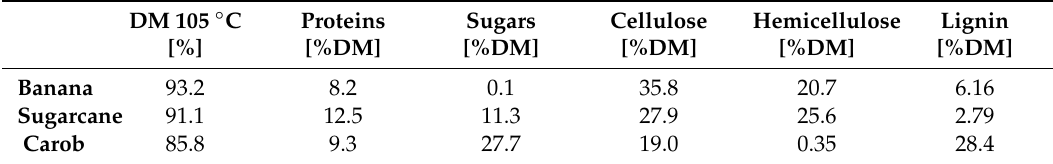
Table 1. Composition of carob, banana peduncle and sugarcane biomass (% of dry matter, DM).